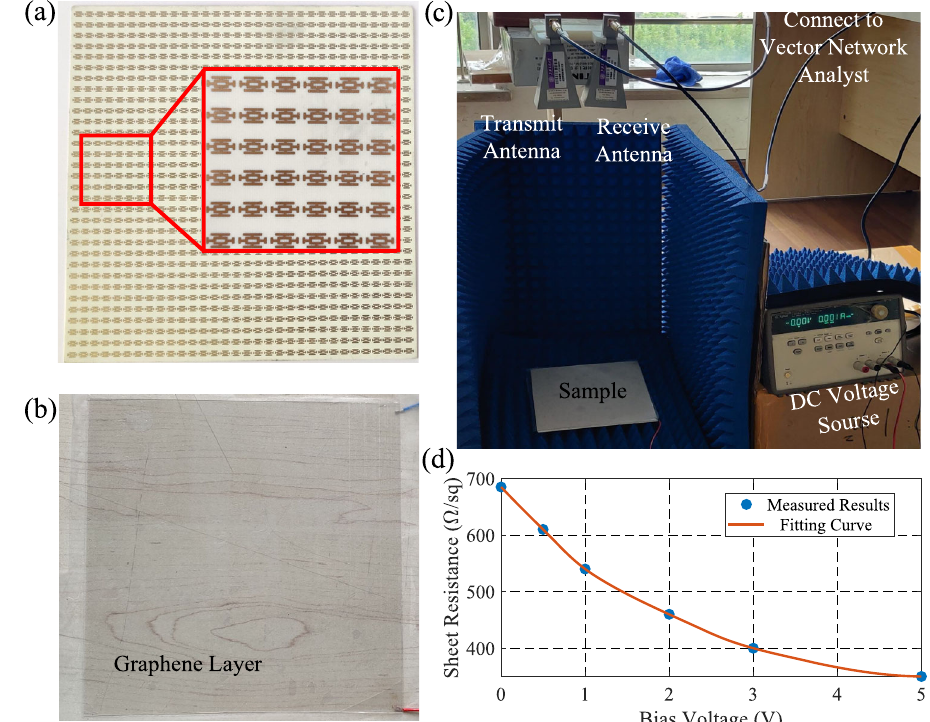
Fig. 6 Prototype and measurement setup. Photograph of a patterned metallic layer, b graphene-based sandwich structure connected to bias voltage, and c measurement setup. d Relation between the bias voltage and sheet resistance of